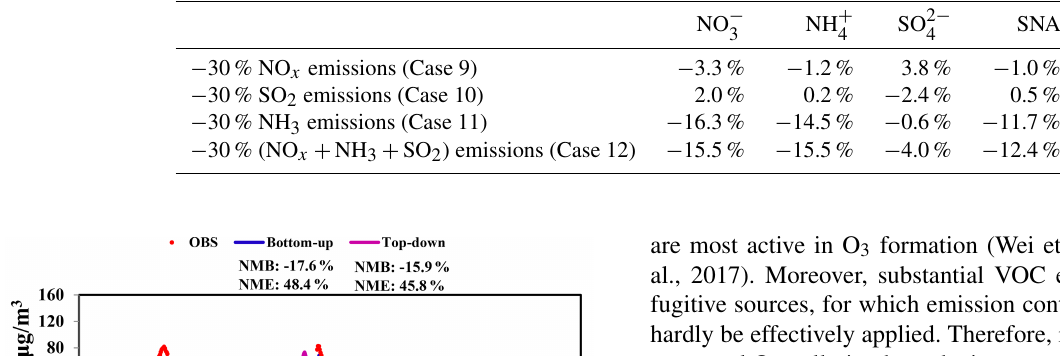
, NH + , and SO 2 − concentrations based on the sensitivity analysis for January 2016. 3 4 4